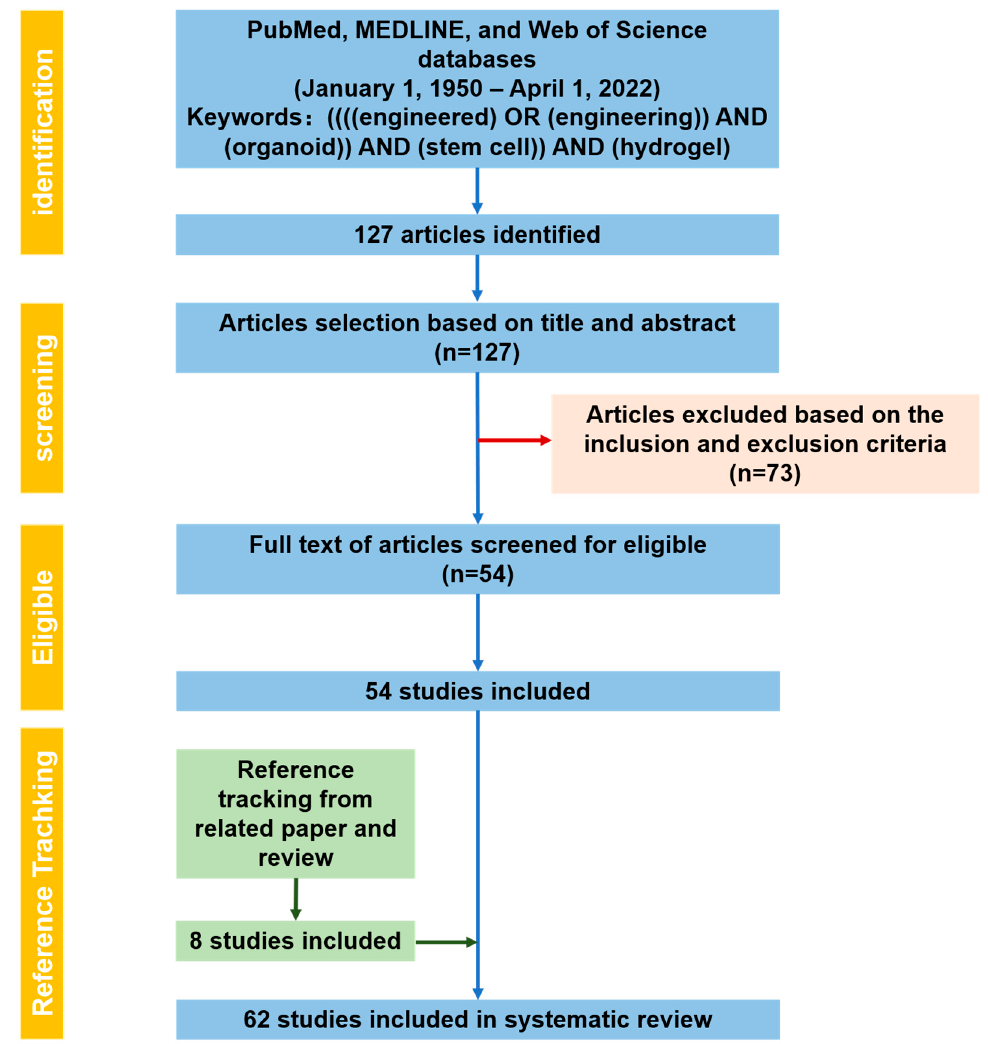
Figure 1. PRISMA flowchart for study selection.